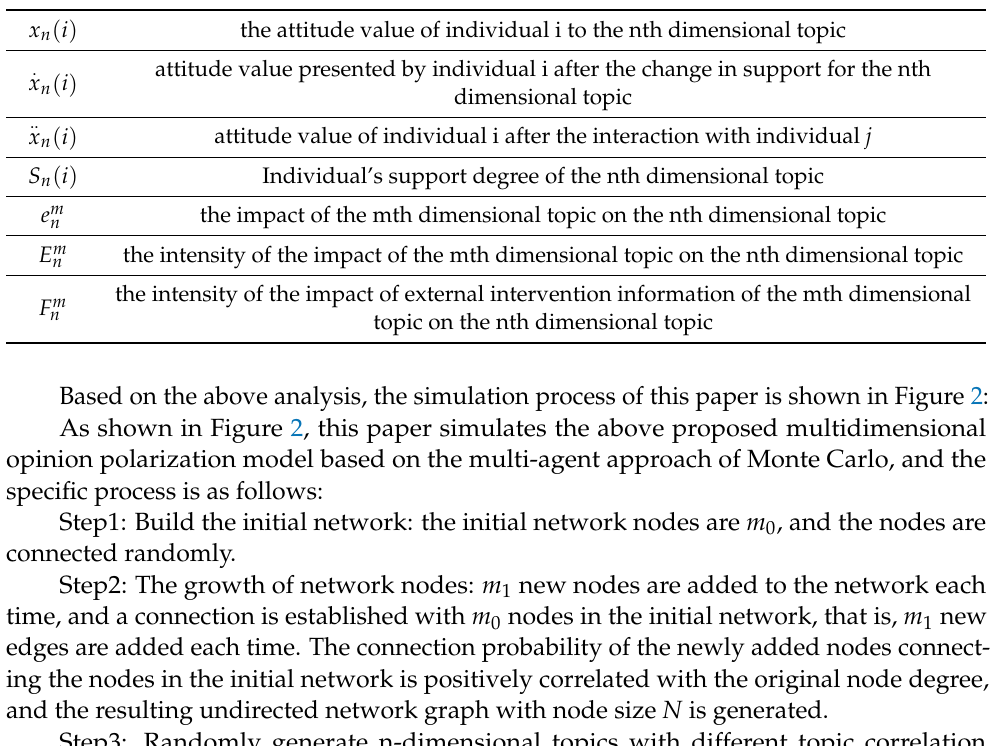
Table 2. Relevant